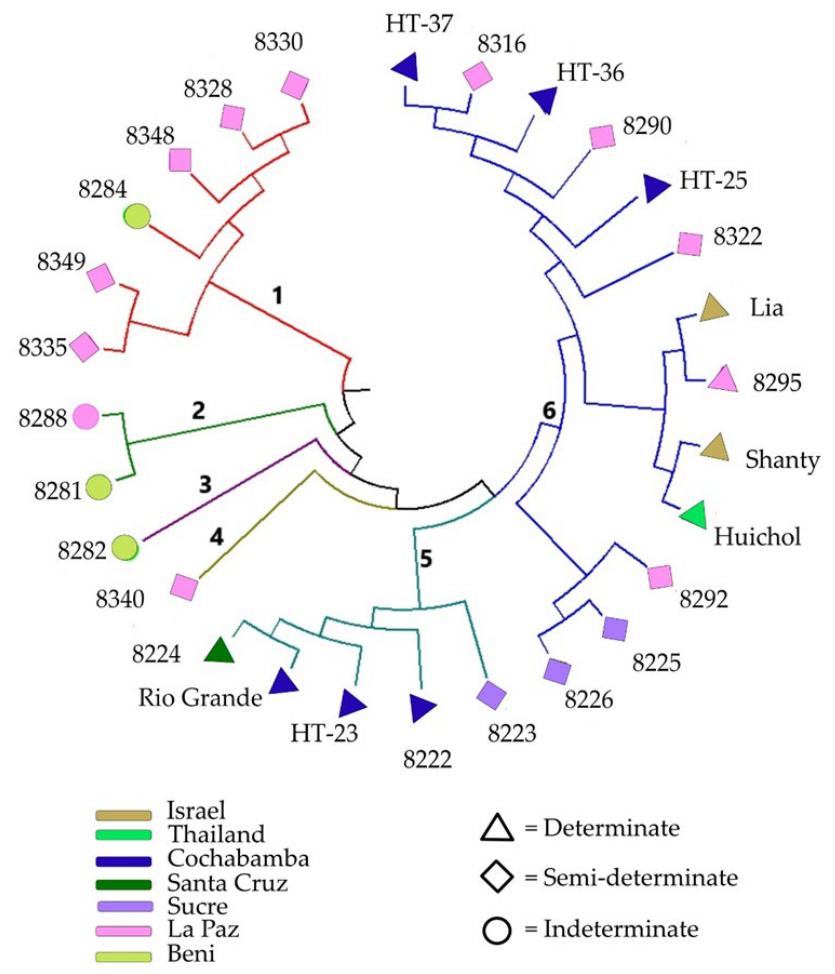
Figure 5. Unweighted pair group method with arithmetic mean (UPGMA) tree showing the genetic relationship between the 28 accessions analysed in the present study. NOTE: Label colour indicates geographical origin of the accessions (regions within Bolivia or other countries), while label shape indicates growth habit (determinate, semi-determinate, indeterminate).